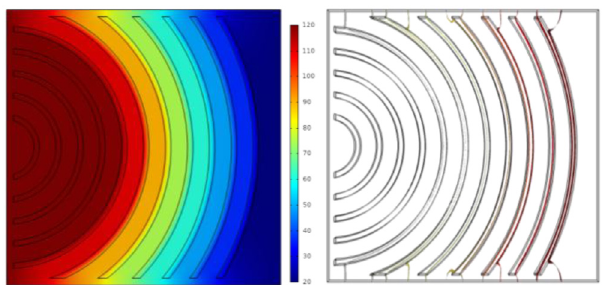
Fig. 5. Temperature signature for a unit cell with concentric circular cuts (left), Isothermal contours established in the area of the unit cell cuts (right).